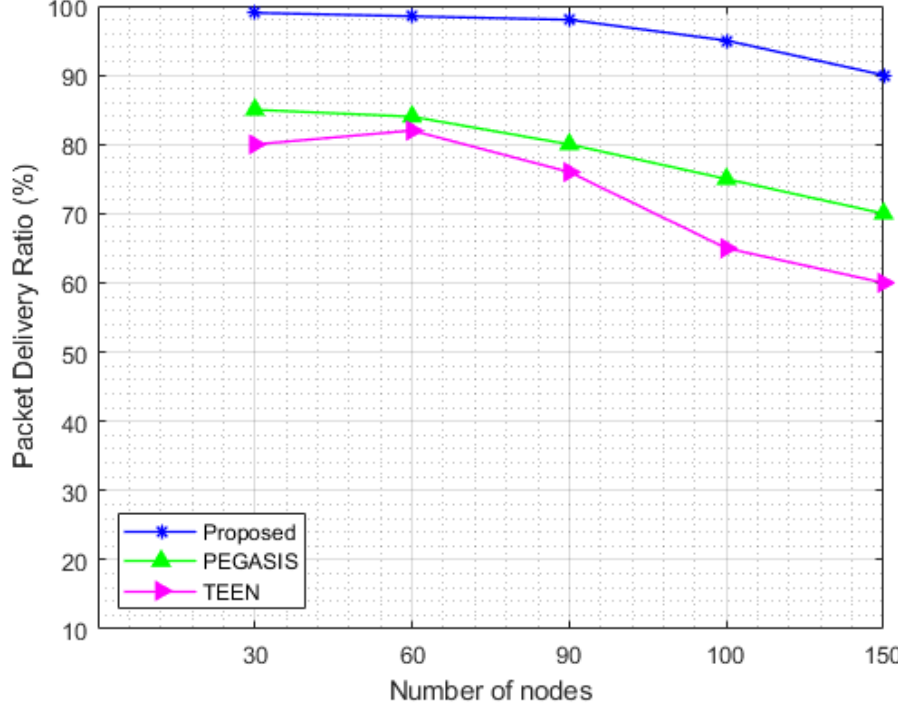
Figure 13. Number of nodes vs. Packet delivery ratio (150 nodes).